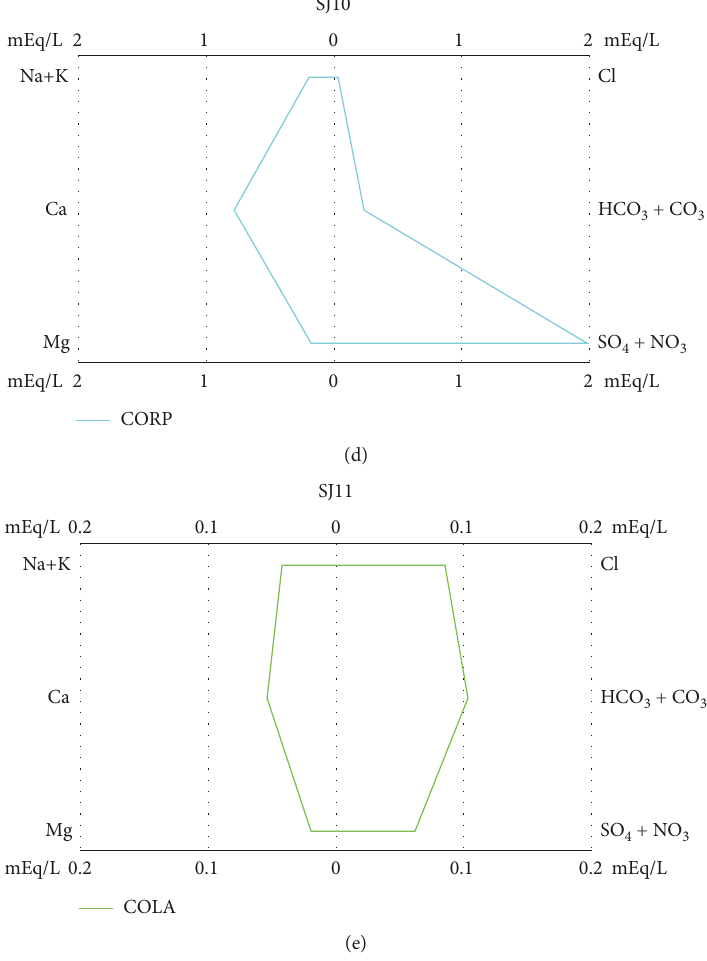
Figure 4: Representative Sti ff diagrams of the sources of the San Juan Figure 7. Here, 2+ and 2 − vs. 1+ and 1 − ion relations presented a linear behavior with a determination coe ffi cient of R 2 = 0 929 in the Coconuco sector and R 2 = 0 620 in the San Juan sector. Note that the SJ1 source does not follow the other sources ’ linear tendency. Sources of the Coconuco sector are located in the upper part of the line with equation y = − 0 654 x − 1 473 (see Figure 7(a)) indicating a cation exchange between Ca 2+ , Mg 2+ , and Na + , which are dominant in the process of hydrogeochemical evolution and the possible dilution of albite rocks at the interior of the deposit.